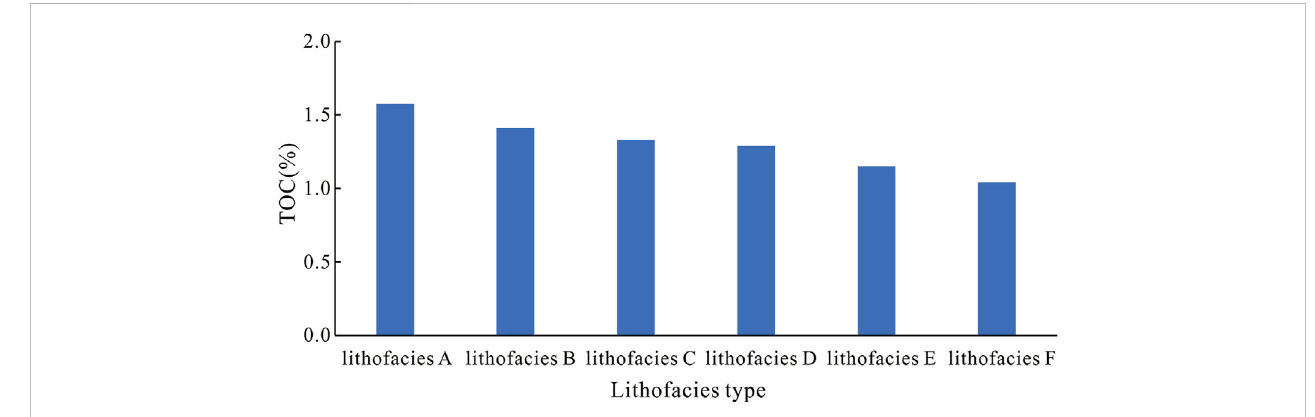
Average TOC content of each lithofacies type from Well RA1.